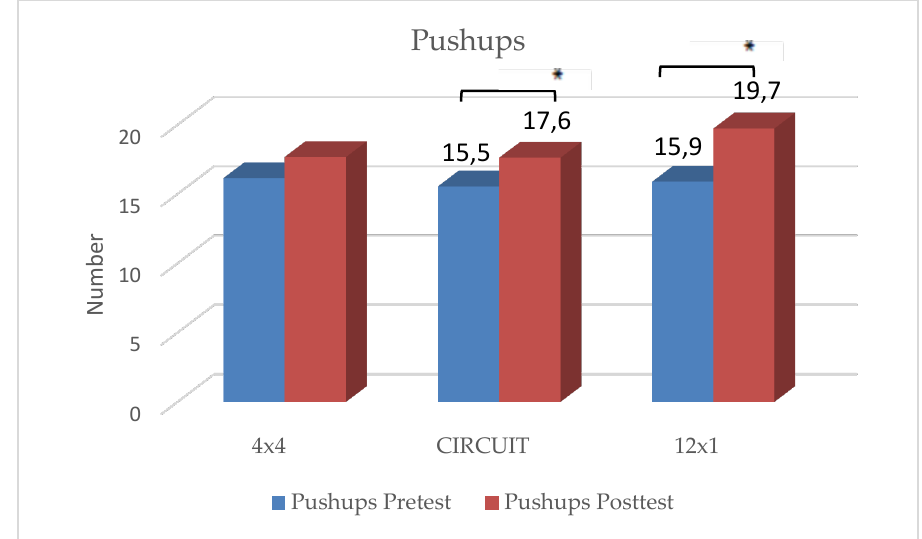
Figure 2. Changes in aerobic endurance capacity within intervention groups . * Significant difference between pre- and posttest ( p < 0.05).